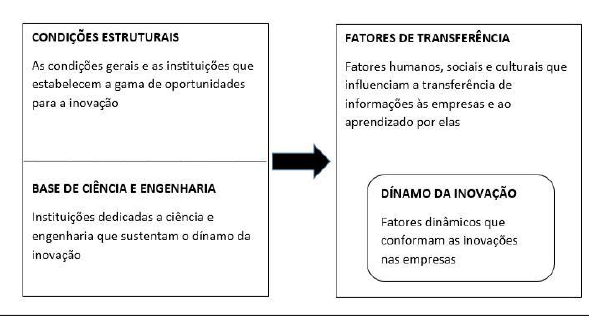
Figure 1. The field of Innovations Policies Source: Adapted from Vasconcellos and Amato Neto